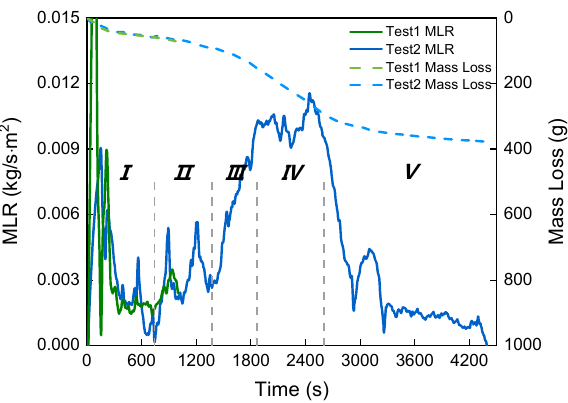
Figure 12. Mass loss rates and mass losses for Cable ZRC-YJV-8.7/10 3 × 95 mm 2 in Test 1 and Test 2. MLR—mass loss rates.